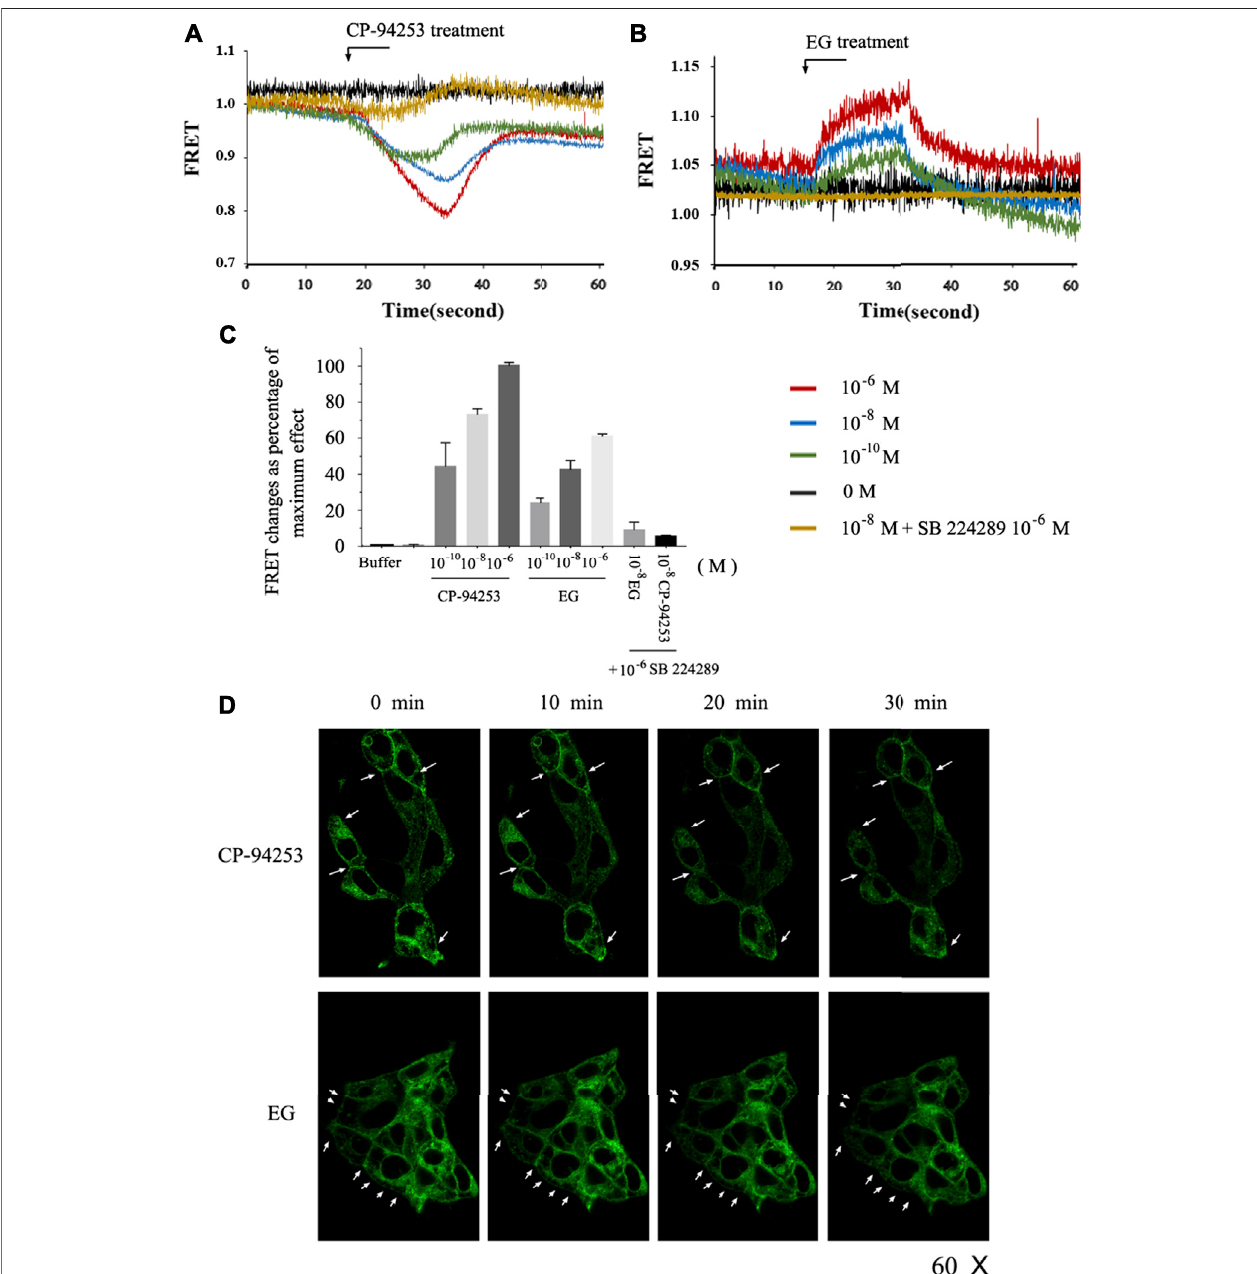
FIGURE 4| Intramolecular FRET sensor imaging ofEG asa 5-HT 1B agonist. (A,B) Flp-In ™ T-REx ™ 293cells induced to express mGluR5-VSV-G-5-HT 1B -FlAsH- CFPshowninFRETimaging.CP-94253 (A) orEG (B) atthreeconcentrations(10 − 10 ,10 − 8 and10 − 6 M)addedattheindicatedtimesandremovedafter15s.FRETsignal was monitored over 60 s. (C) Changes in normalized FRET signals due to ligand addition and effect of 10 − 6 M CP-94253 de fi ned as 100% and vehicle as 0%. 5-HT 1B receptorantagonistSB224289 did notmodulatemGluR5-VSV-G-5-HT 1B -FlAsH-CFP FRETsignals,but co-additionwithCP-94253or withEGblockedagonists ’ effects. Studies were quanti fi ed, and data are represented as means ± S.E., n (cid:2) 6. (D) Flp-In ™ T-REx ™ 293 cells induced to express mGluR5-VSV-G-5-HT 1B -FlAsH- CFP imaged to detect CFP following addition of CP-94253 or EG (10 − 7 M). CP-94253 or EG-induced internalization, reducing the cell surface mGluR5-VSV-G-5-HT 1B - FlAsH-CFP in atime-dependent fashion. Representativeexamplesofn (cid:2) 3independent experiments areshown. FRET: fl uorescence resonance energytransfer; FlAsH: fl uorescein arsenical hairpin binder via tetra-cysteine; CFP: cyan fl uorescent protein; VSV: vesicular stomatitis virus; EG: emodin-8-O- β - D -glucopyranoside; CP-94253: 4-{5-propoxypyrrolo [3,2-b]pyridin-3-yl}-1.2,3,6-tetrahydropyridine; SB 224289 [4-[2-methyl-4-(5-methyl-1,2,4-oxadiazol-3-yl)phenyl]phenyl]-(1 ′ -methylspiro [6,7- dihydro-2H-furo [2,3-f]indole-3.4 ′ -piperidine]-5-yl) methanone; 5-HT 1B : serotonin receptor 1B; mGluR5: metabotropic glutamate receptor 5; FlAsH: fl uorescein arsenical hairpin binder via tetra-cysteine.